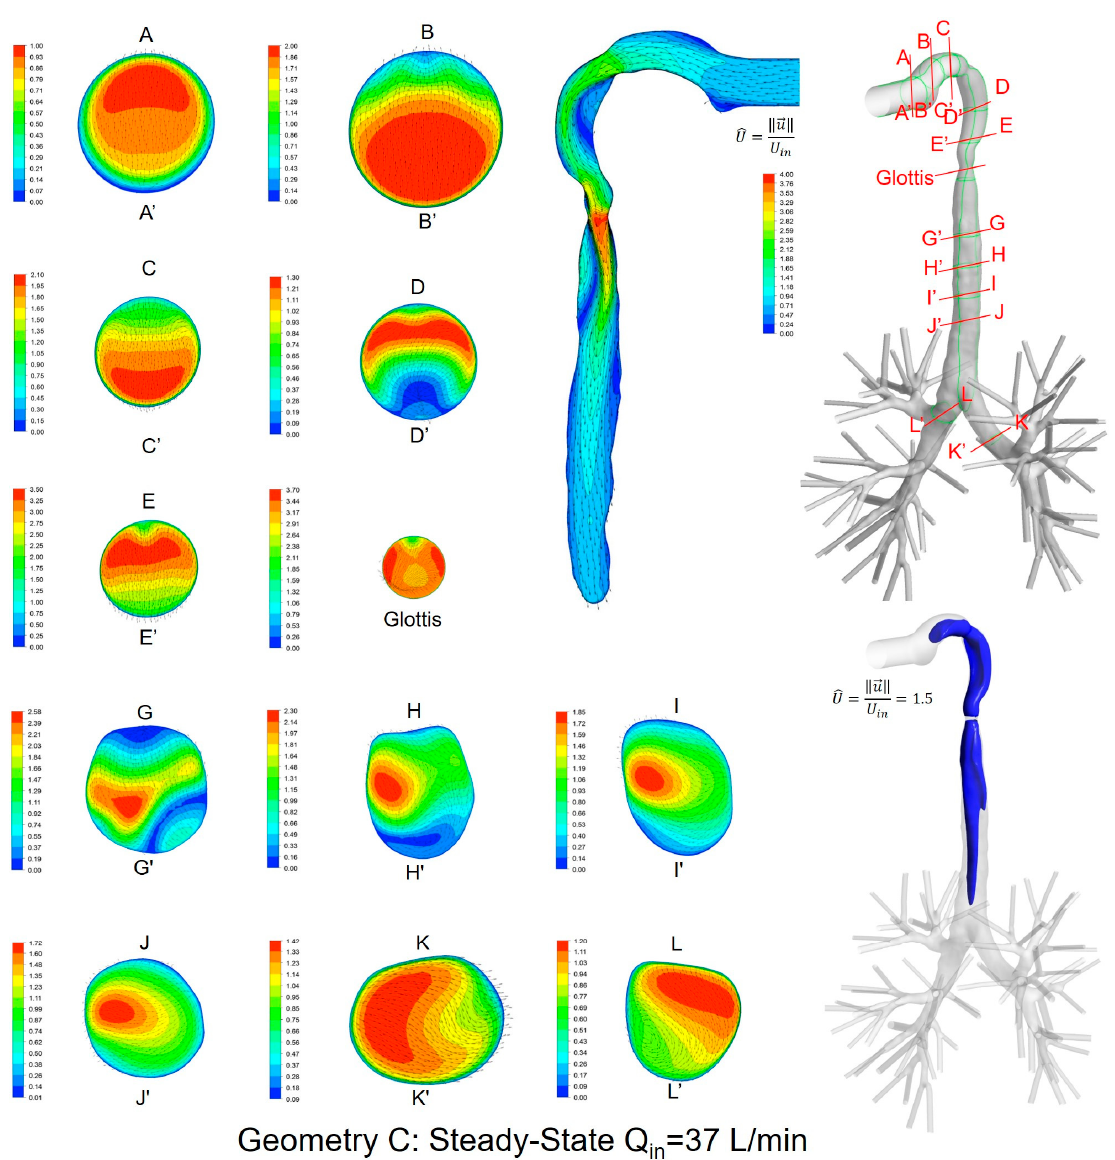
Figure 8. Dimensionless velocity distributions and laryngeal jet core at multiple cross-sections and the sagittal plane of Geometry C under a steady-state inhalation flow rate of Q in = 37 L/min.